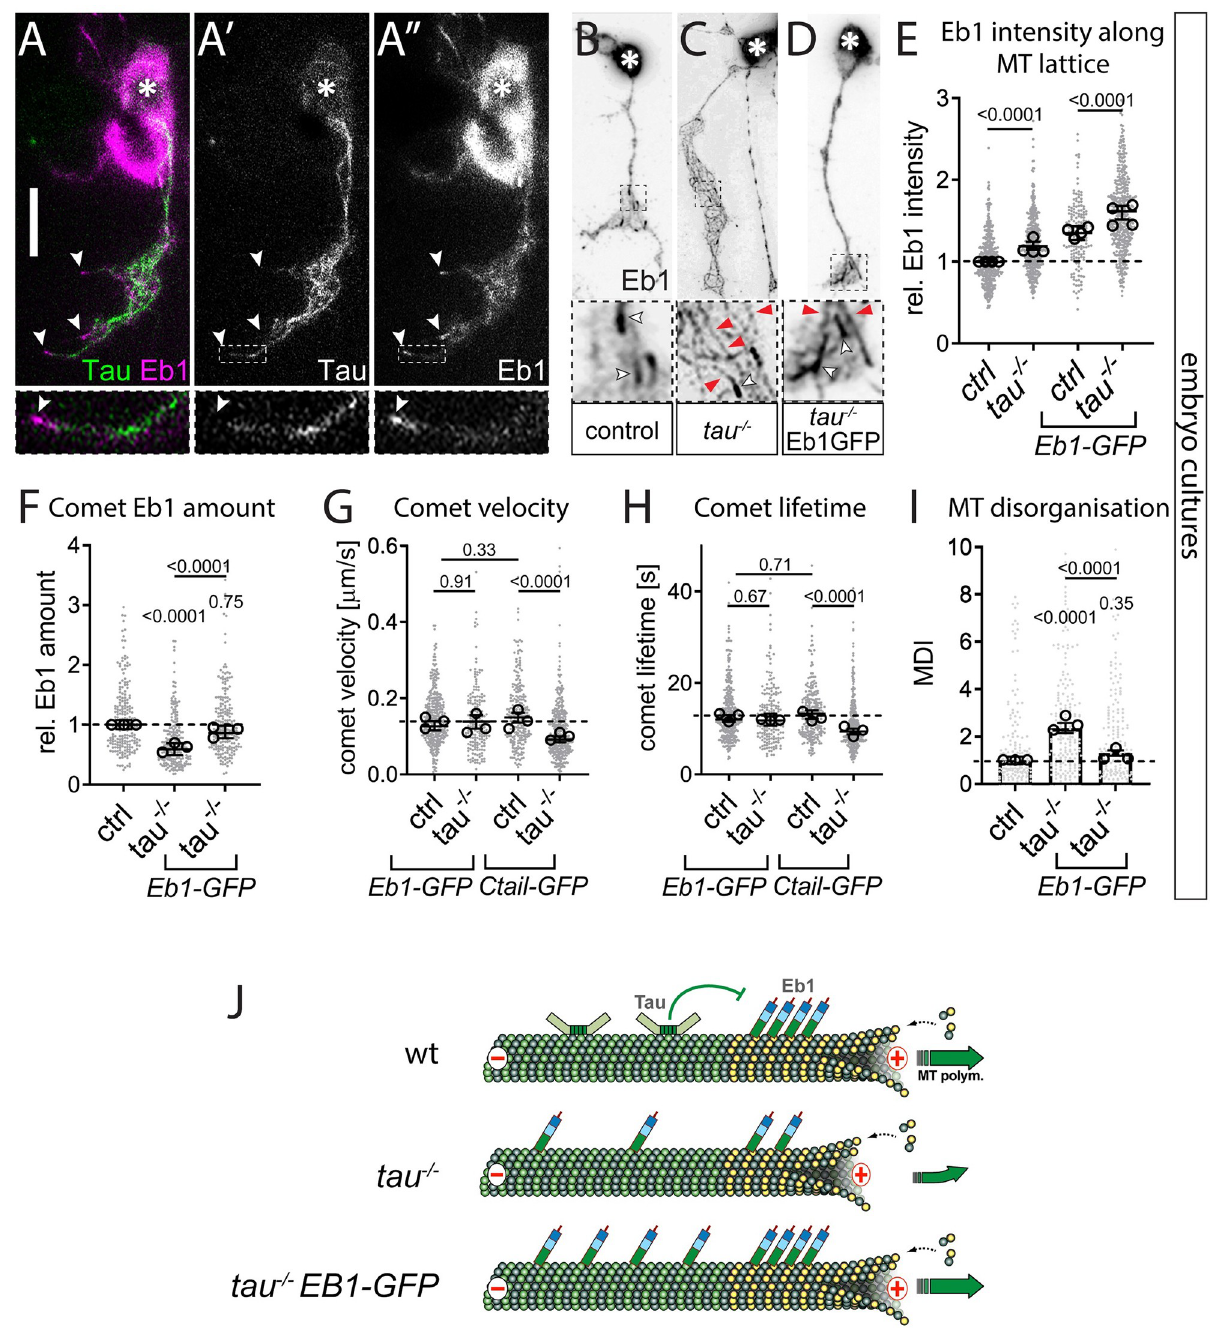
Fig 5. Tau promotes Eb1 pools at MT plus-ends by outcompeting Eb1’s association with the MT lattice. A-A” ) Example of an embryonic neuron at 6 HIV imaged live with curling MTs to illustrate Tau binding (green) along the MT lattice, separated from Eb1 comets (magenta); asterisks indicate the soma, the scale bar represents 10 μ m, dashed boxes indicate the positions of the 4-fold magnified close-ups shown at the bottom, white arrowheads point at Eb1 comets (same in B-D). B-D ) Primary neurons at 6 HIV stained for Eb1 which are either wild-type (B) or mutant for tau KO/Df (C) or expressing Eb1::GFP driven by elav-Gal4 in tau KO/Df mutant background (D); white arrowheads indicate Eb1 comets, red arrowheads Eb1 lattice localisation. E-I ) Different parameters (as indicated) of control (ctrl) or tau KO/Df ( tau -/- ) mutant neurons at 6 HIV without/with elav-Gal4 -driven expression of Eb1::GFP or Shot-Ctail::GFP (as indicated); data were normalised to parallel controls (dashed horizontal lines) and are shown as scatter dot plots with mean ± SEM (I) or median ± 95% confidence interval (E-H) from at least two independent repeats with 3 experimental replicates; large open circles in graphs indicate median/mean of independent biological repeats. P-values obtained with Kruskal-Wallis ANOVA and Dunn’s posthoc test as shown above data points/bars. J ) Model view of the results shown here; note that yellow circles represent GTP-tubulin which provides higher affinity for Eb1 binding; for further explanations see main text and Discussion. For raw data see S5 Data.